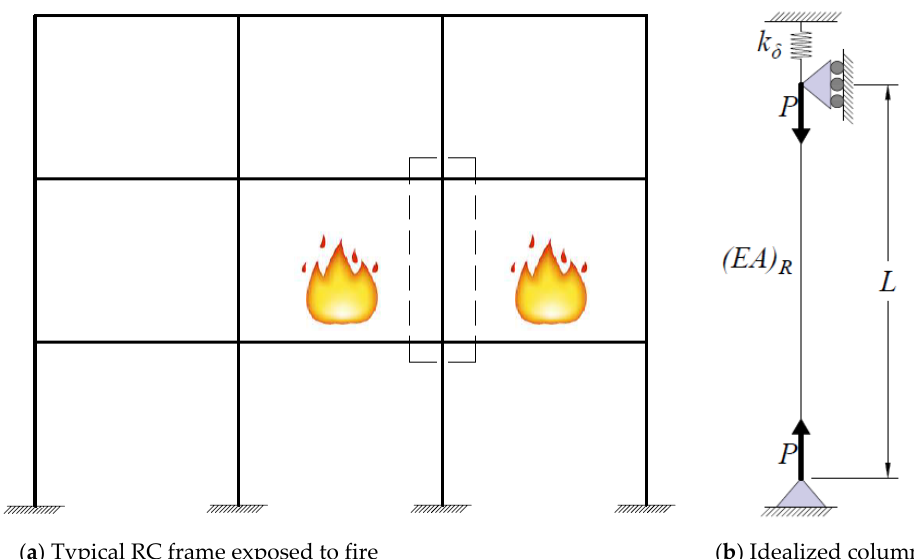
Figure 3. Isolation of a fire-exposed column in a typical RC frame.